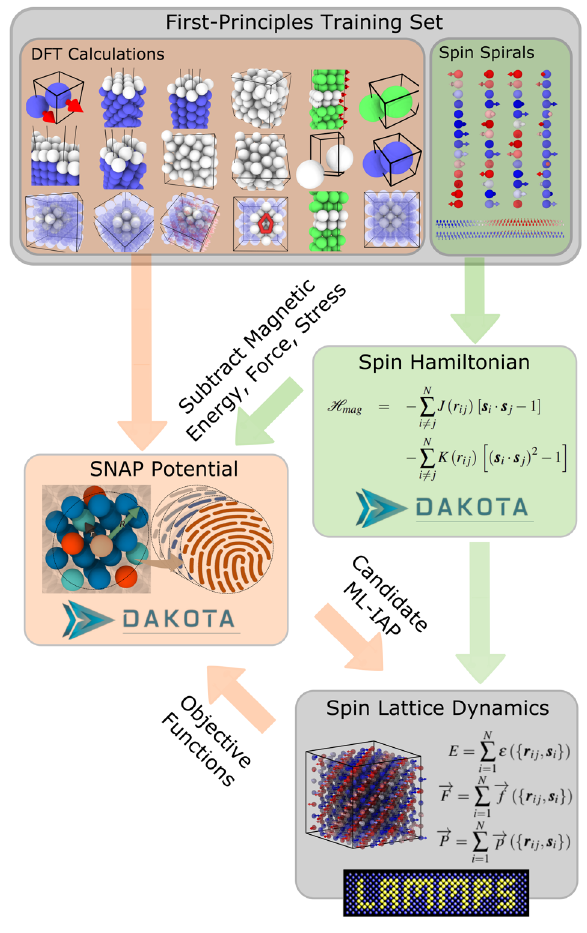
Fig. 2 Magneto-elastic ML-IAP training work fl ow. A training set of DFT calculations is partitioned into those that train the SNAP interatomic potential and those that train the spin Hamiltonian, respectively. A non-magnetic interatomic potential is fi t to con fi g- uration energies and atomic forces after the spin Hamiltonian contribution is subtracted and is validated against magneto-elastic properties computed in LAMMPS. Optimization of the spin Hamiltonian and interatomic potential parameters is handled by